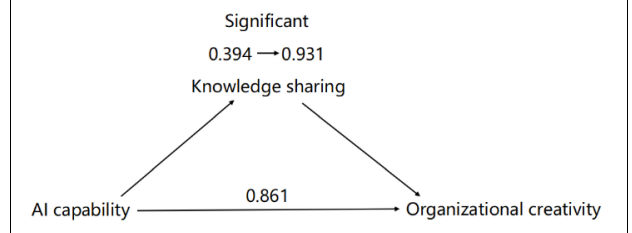
FIGURE 2 | Intermediary role test results.